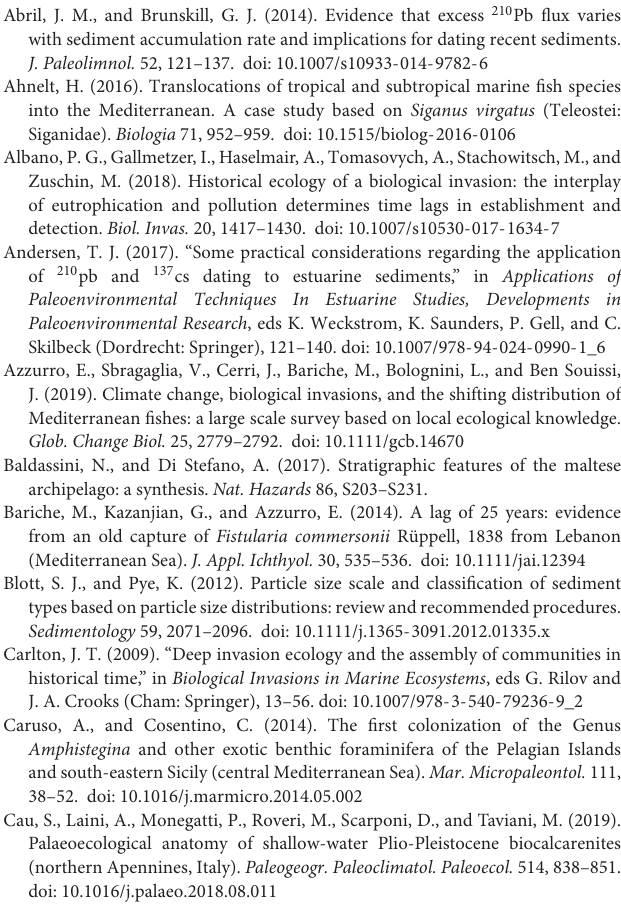
Supplementary Table 3 | Radiometric data and chronological constrain based on 210 Pb decay.